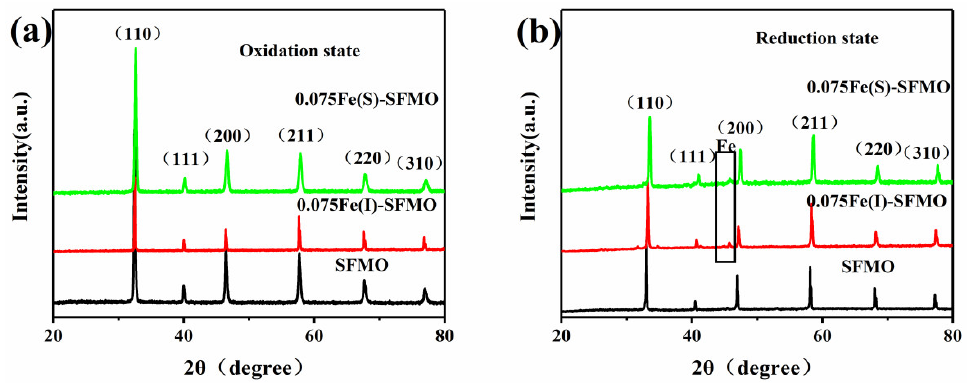
Figure 2. XRD characterization of SFMO samples. XRD patterns of samples after pretreatment in ( a ) air and ( b ) 5% H 2 /Ar.